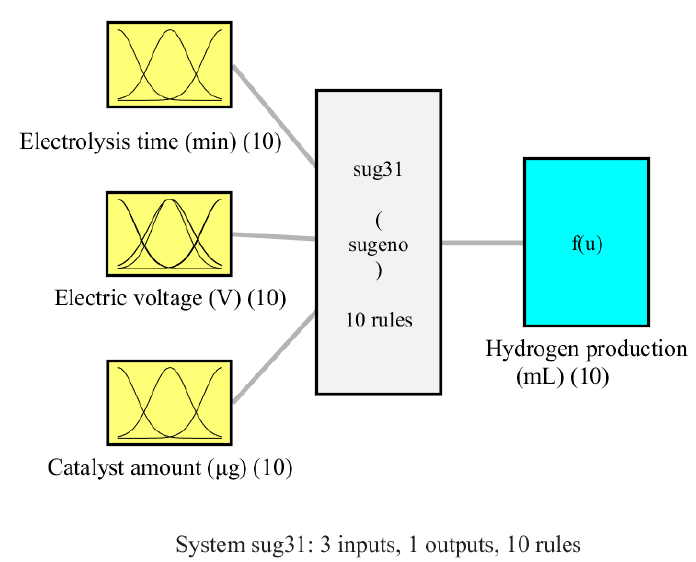
Figure 3. Arrangement of the ANFIS model of the water electrocatalysis process.